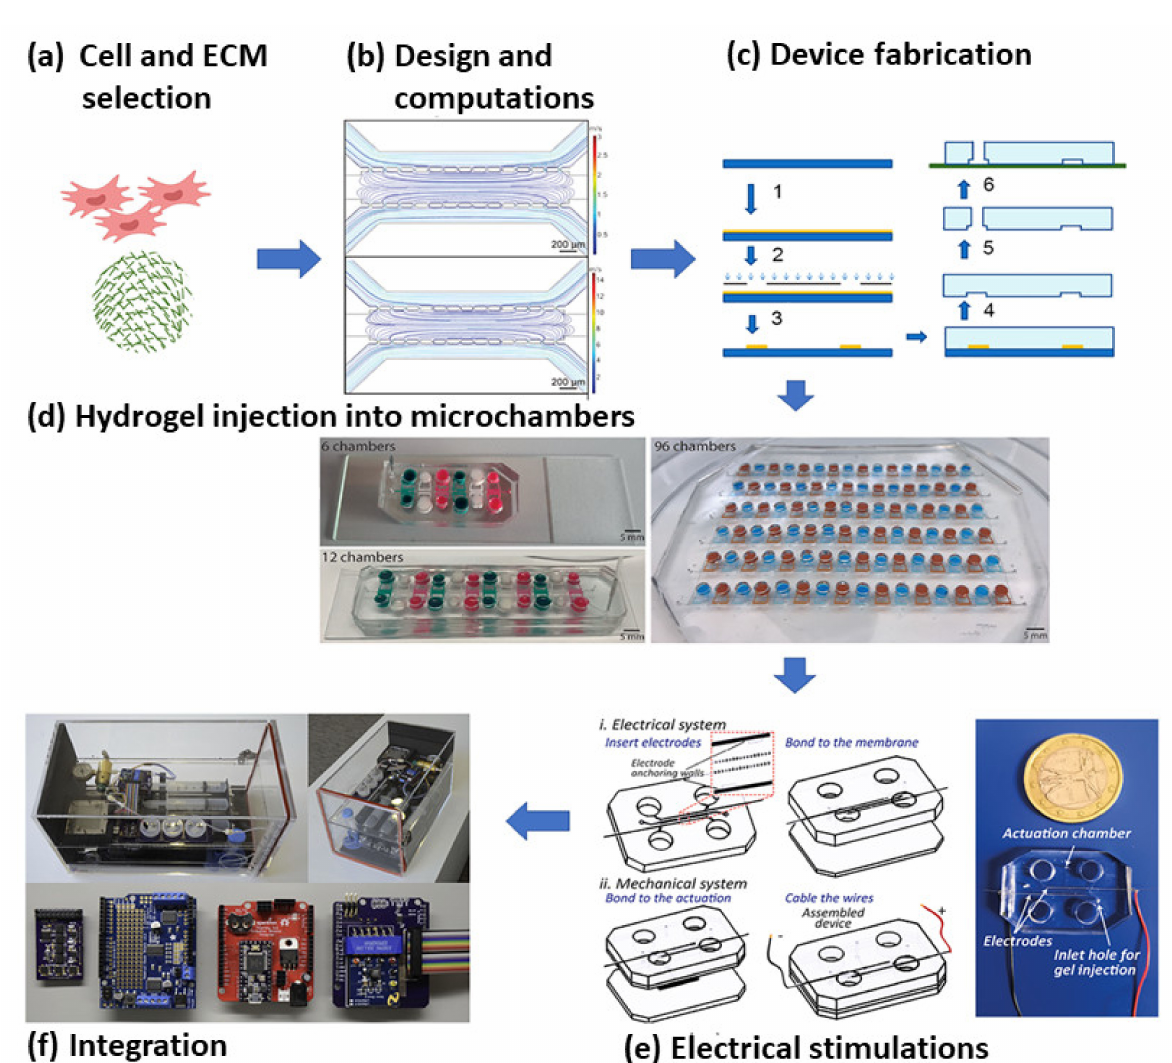
Figure 5. Steps in microfluidic cardiac model generation—( a ) Selection of cells and extracellular matrix are performed based on the physiology to be studied; ( b ) this is followed by design of the chip through different computational software to achieve the desired flow contours; ( c ) based on the design, the device is fabricated by various microfabrication procedures (the most common being photolithography; the steps of which are 1. spin coating of clean silicon wafer, 2. UV exposure with a mask, 3. dissolution of unwanted resist with developer solution to generate the master pattern, 4. PDMS mold creation from the master pattern, 5. punching of required inlet and outlet holes in the PDMS mold, and 6. bonding of the PDMS mold with a glass plate or another PDMS slab to close the device); ( d ) introduction of cell-laden hydrogel into the device for 3D culture (its selection is based on the mechanical properties needed for the micro tissue under study; ( e ) completion of the electrical circuit required for stimulation of the cardiac cells; ( f ) integration of the device with external circuitry and pumping mechanism for seamless operation of the chip